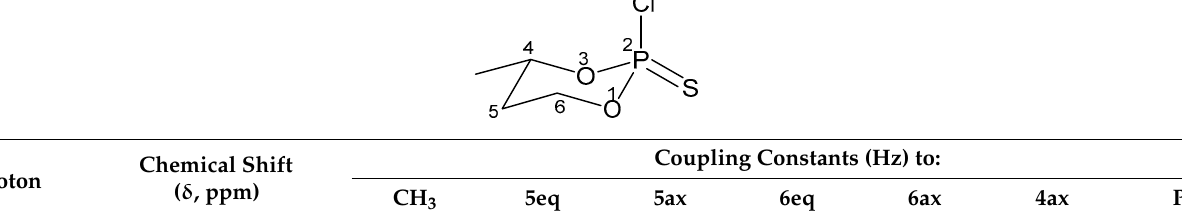
Table 1. 1 H-NMR data for trans-2-chloro-4-methyl-1,3,2-dioxaphosphorinan-2-thione 6 ( Cl ) in carbon tetrachloride solution at 270 MHz; atom numbering in the ring shown below.